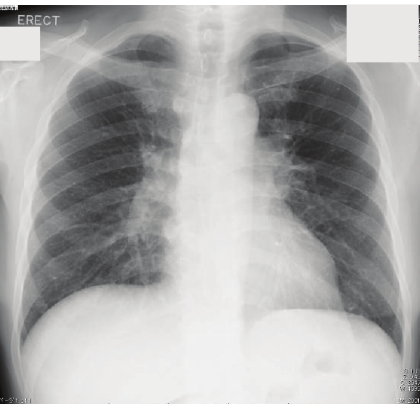
Figure 1: Chest radiography. Reticular and nodular shadows in both lower lobes of the lungs and enlargement of the pulmonary